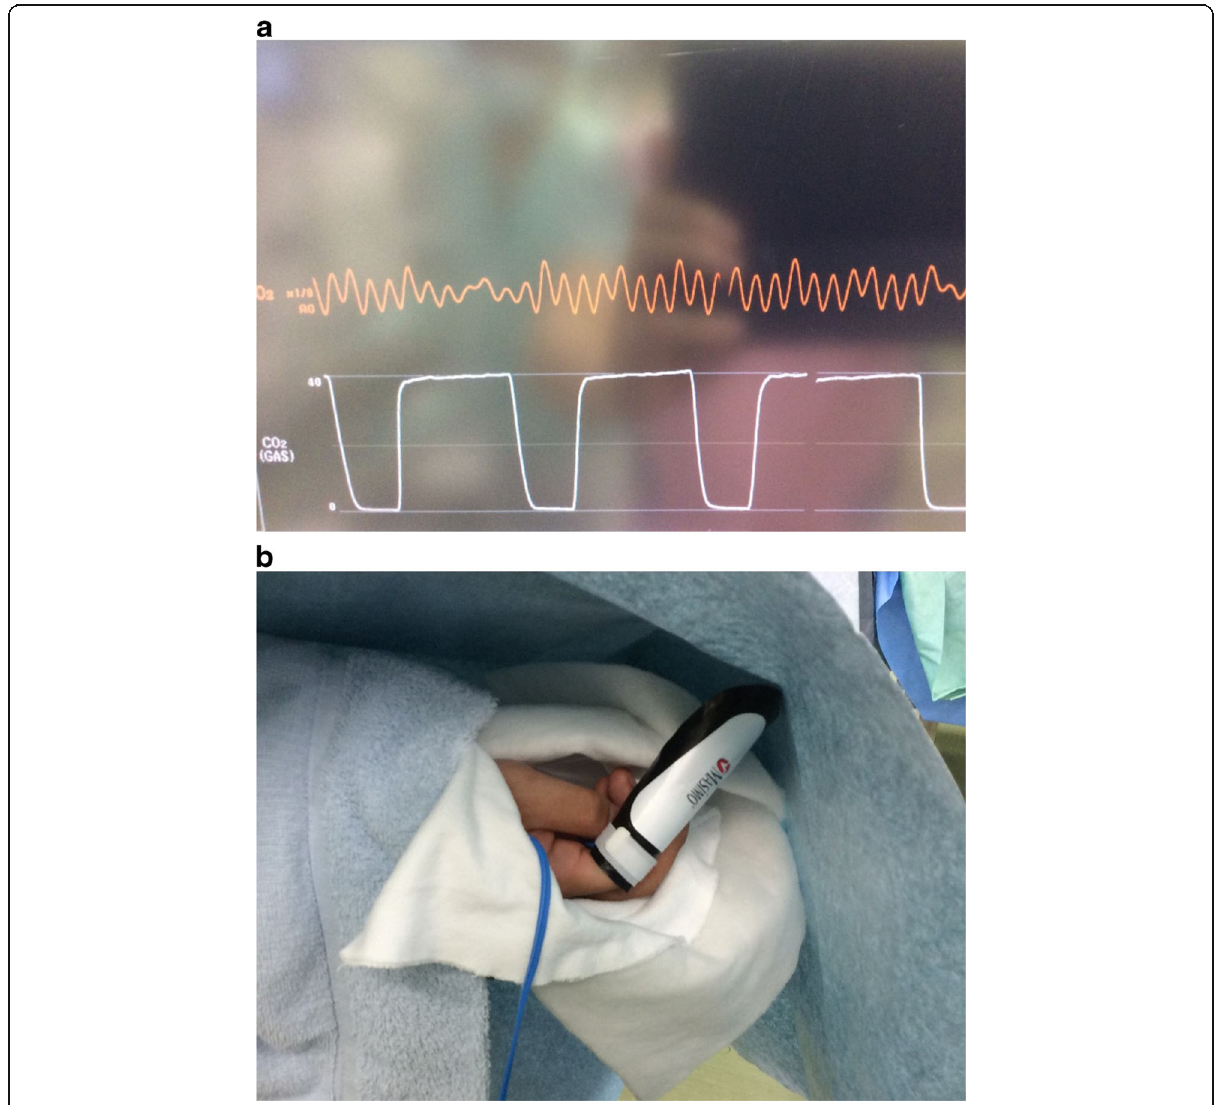
Fig. 1 a Pulse oximetry plethysmogram with interference. b A black plastic shield to eliminate the interfering